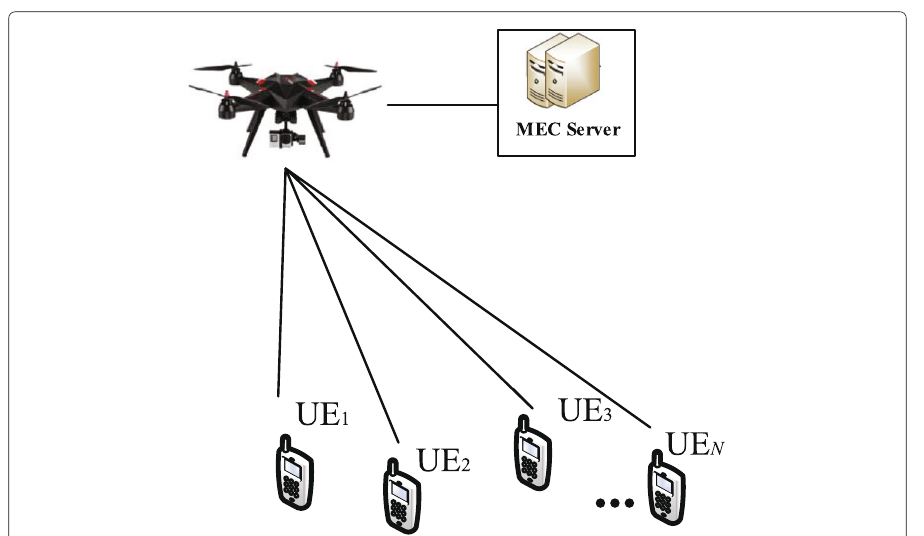
Fig. 1 The UAV-assisted MEC system